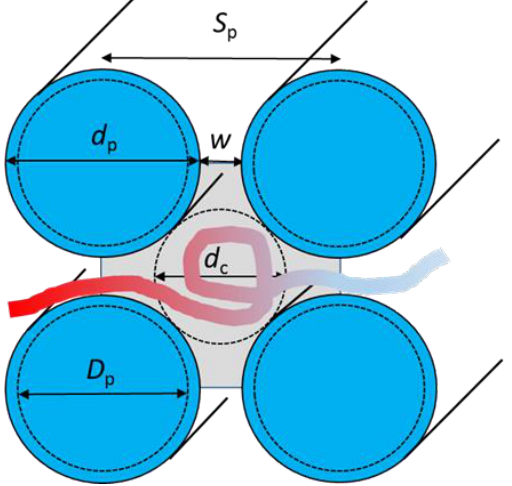
Figure 1. Scheme of the cross-sectional view through four adjacent nanoposts defining the parameters described in the main text.